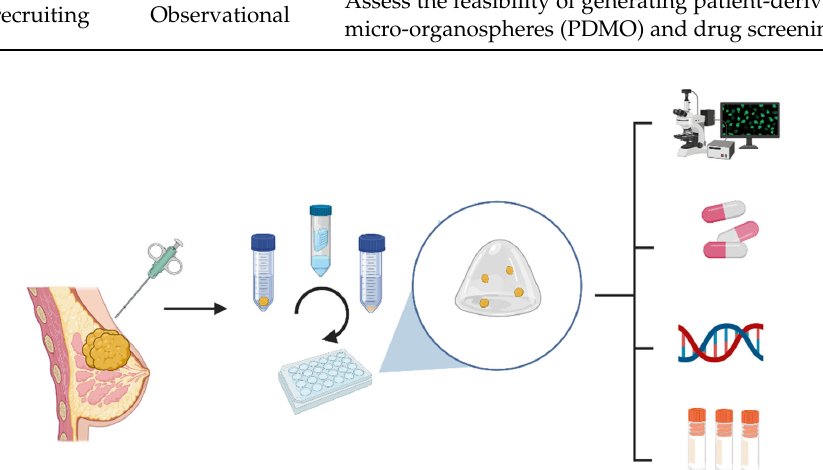
Figure 3. Organoids processing. After collecting fresh tumor tissue, the sample is digested enzymati- cally and seeded in a gel dome. After several weeks of growing, this model can be used for different purposes, such as: staining characterization, drug-screening, genomic characterization and